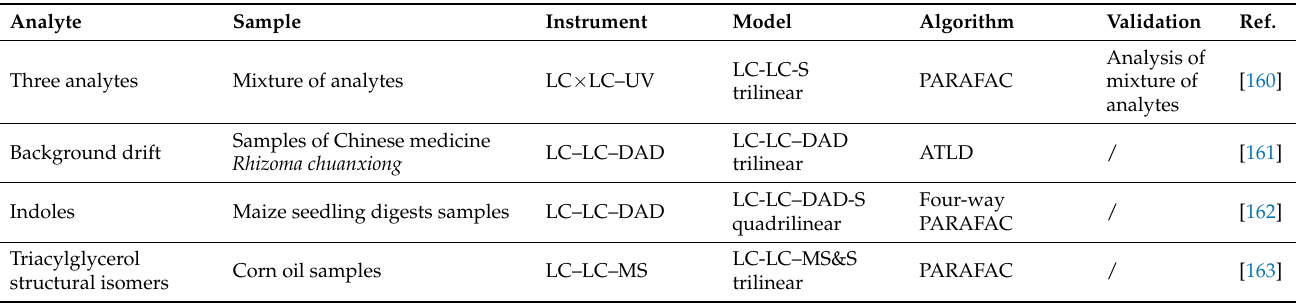
algorithm on the LC–LC–MS&S trilinear model to resolve triacylglycerol structural isomers in a corn oil sample. Table 6. Analytical applications of comprehensive two-dimensional liquid chromatography–ultraviolet detector (LC × LC– UV), comprehensive two-dimensional liquid chromatography–diode array detector (LC × LC–DAD), and comprehensive two-dimensional liquid chromatography–mass spectrometry (LC × LC–MS) assisted by multiway analysis based on the multilinear